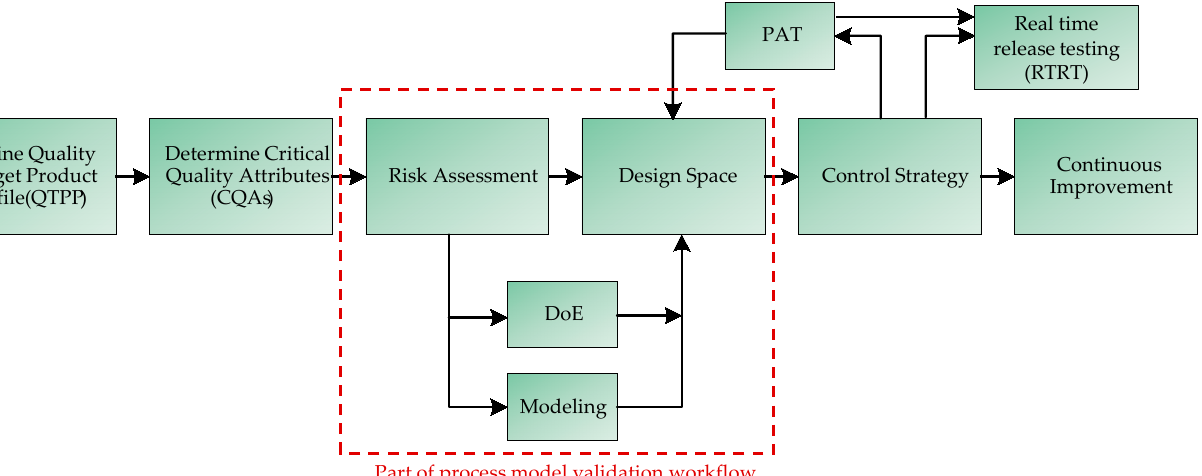
Figure 1. Workflow of model validation based on a QbD-oriented approach [37]. In a first step, the QTPPs are defined. Subsequently, the CQAs are defined and a risk assessment of the influence of various process parameters on the CQAs is carried out. The risk assessment results in a design space for the process parameters to be investigated, which can be examined either via experiments or by means of a rigorous process model. Based on the results, a control strategy is defined, which can be continuously compared online via PAT with the actual state of the system. Strict implementation of this strategy allows for continuous process